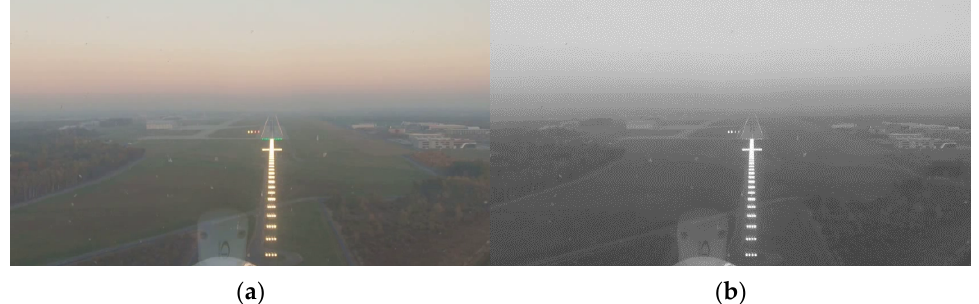
Figure 5. Raw picture of the PAPI light s system: ( a ) the raw runway light image; ( b ) the runway light image in grayscale. The picture was taken approaching the Rzeszow, Jasionka (EPRZ) runway 27, in September, in the late afternoon on a sunny day. The sensor was installed inside the cockpit of the experimental airplane.